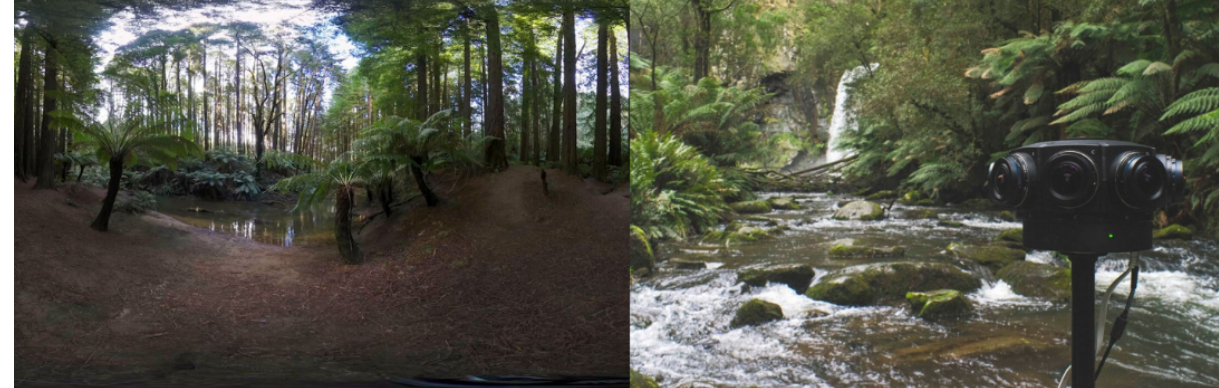
Figure 1. Filming locations for the virtual reality mindfulness app. The image on the left shows the environment presented for the first half of the mindfulness practice. The image on the right shows the second environment as well as the camera used to capture the omnidirectional